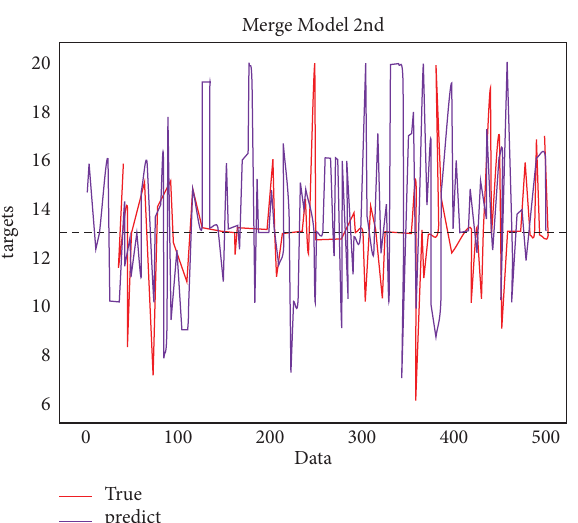
Figure 6: Comparison of the multilayer combination test set of the random